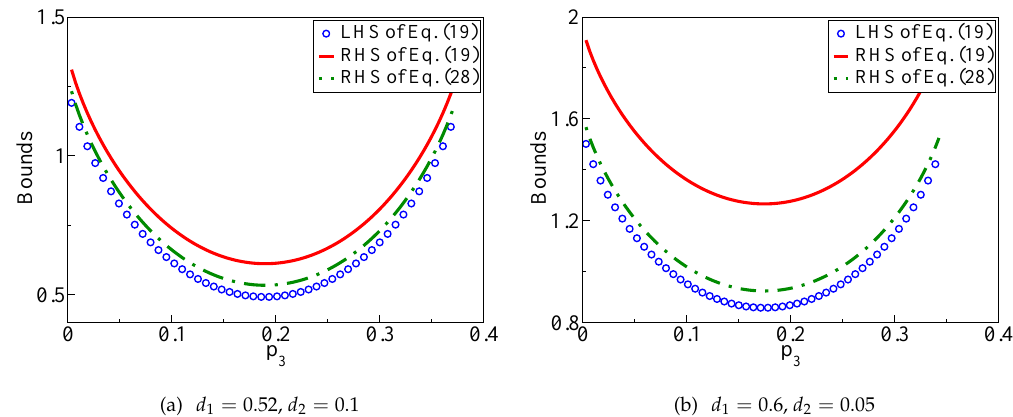
Figure 1. The plot shows the left hand and right hand sides of the uncertainty like relations for quantum coherence, given by Equations (19) and (28), for Bell diagonal states. It clearly shows that the bound in Equation (28) is tighter than that in Equation (19). ( a ) d 1 = 0.52, d 2 = 0.1; ( b ) d 1 = 0.6, d 2 =